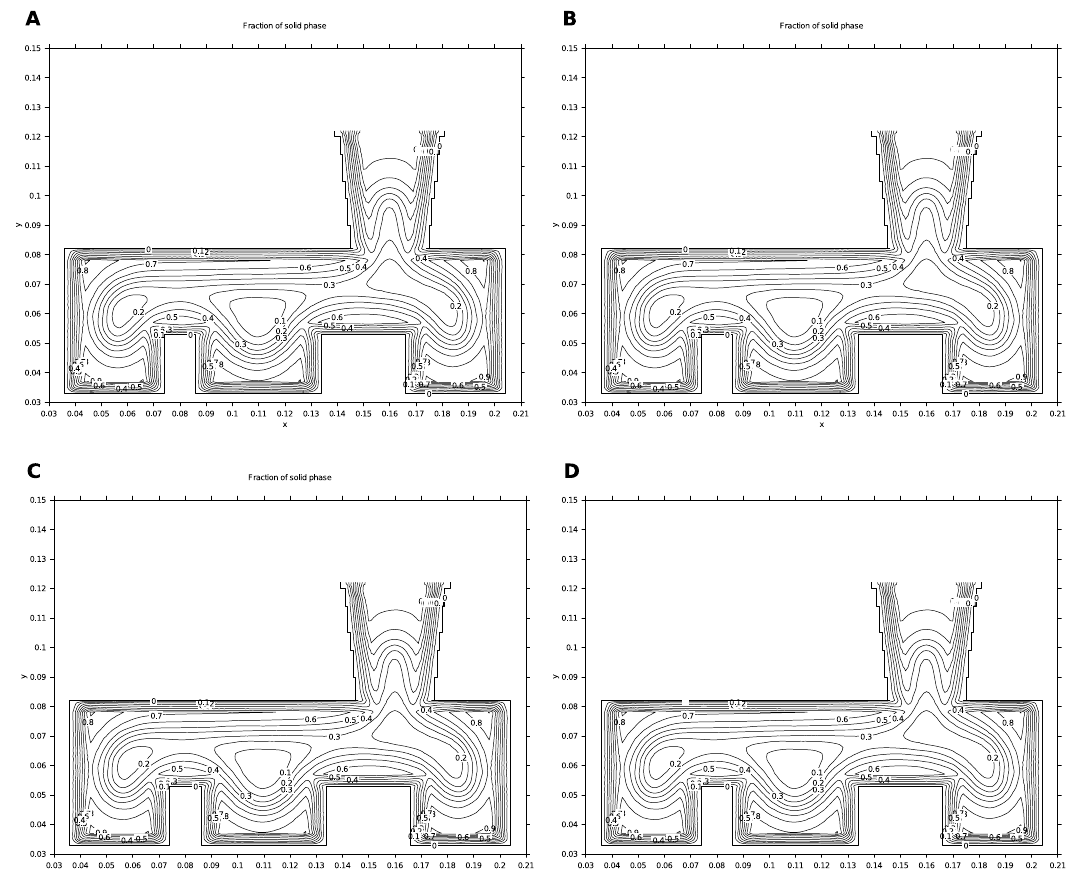
Figure 14. Solid phase fraction in whole casting domain. Four combination of the time integration